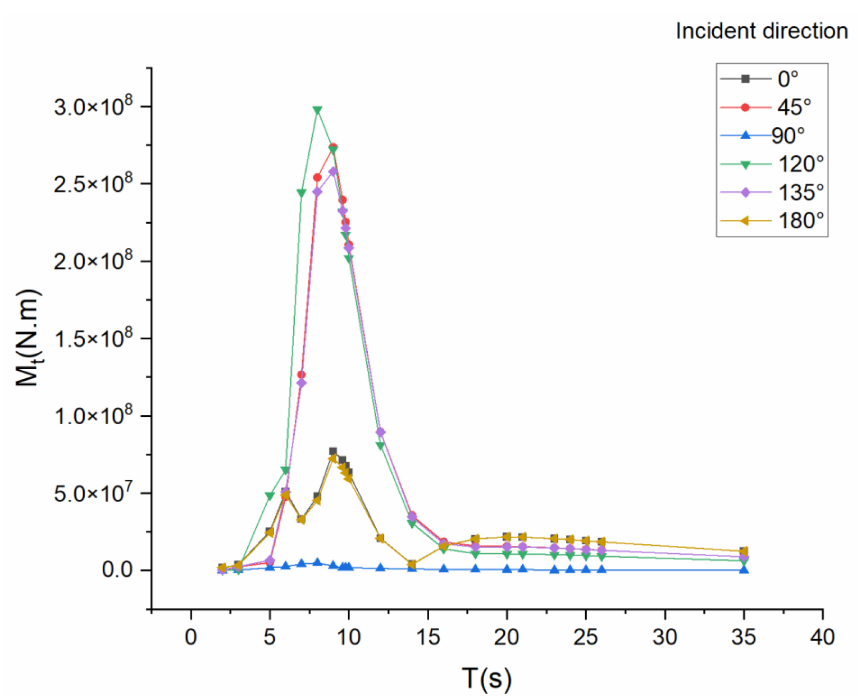
Figure 6. RAO of torsion